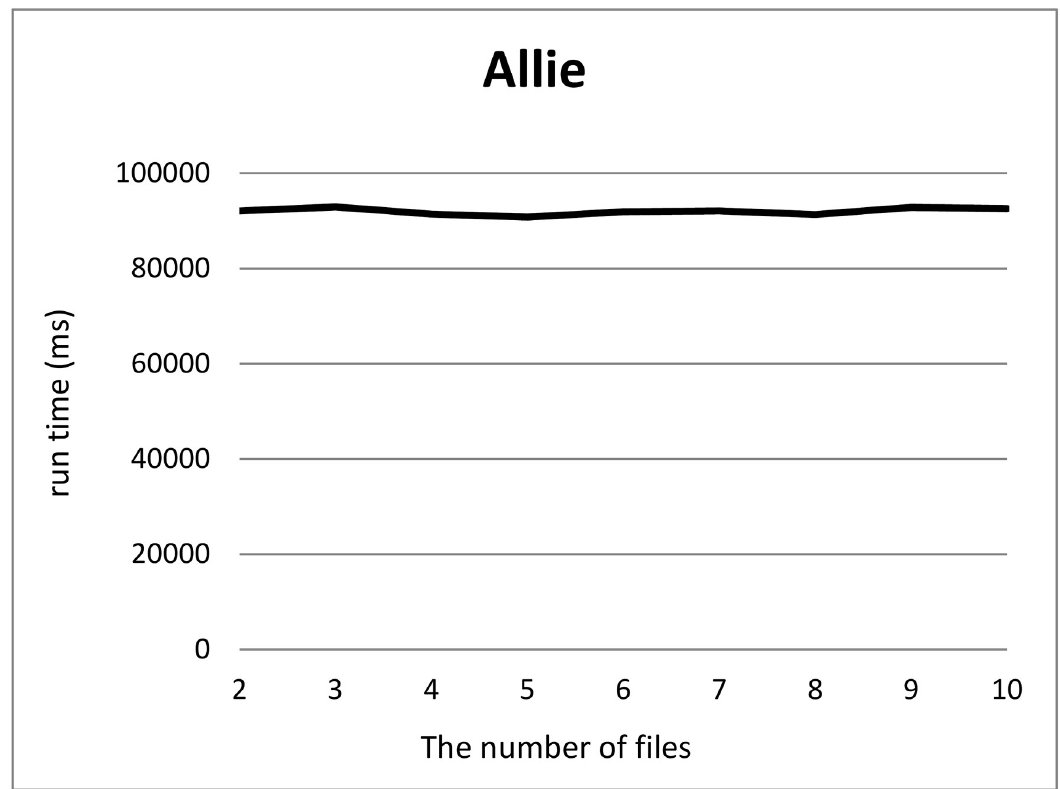
Fig 1. Computation time to split the Allie dataset. x -axis and y -axis correspond to the number of files from two to ten and the average of running time [ms], respectively.